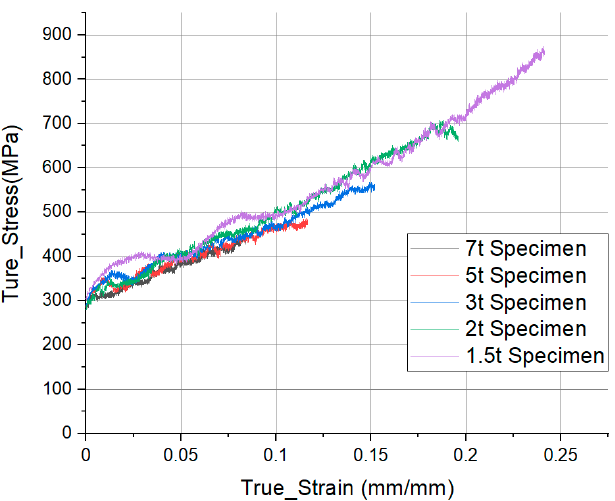
Figure 4. Experiment data: True strain and stress (S-S) curve for specimens of different thicknesses in 1.0 bar condition.